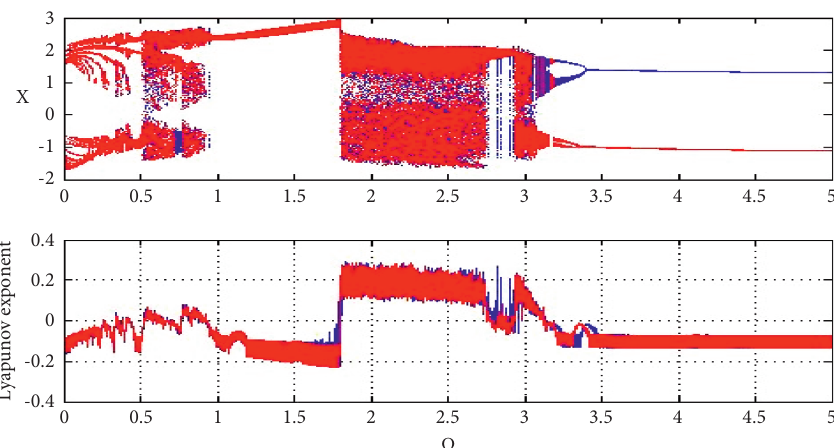
Figure 14: Bifurcation diagrams and its corresponding Lyapunov exponents vs. Ω with f � 1 . 8, α parameters are kept